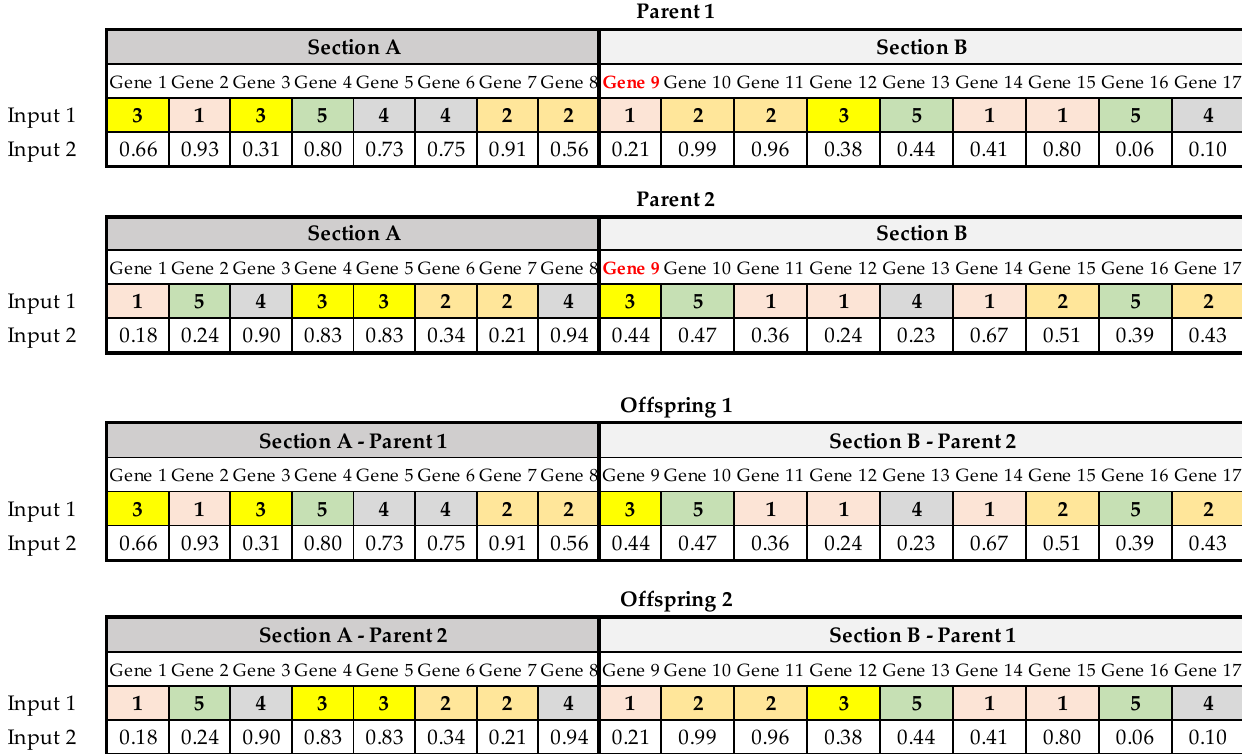
Figure 7. Crossover operator based on single crossing point. The mutation operator is applied after creating the offspring alphas, generating a random number for each offspring. If this random number is less than the probability of mutation MR, the mutation operation is performed using the swapping mutation method (exchange mutation), where two randomly chosen genes are exchanged through a SWAP movement [36,37] (see Figure 8). Figure 8. Mutation operator based on SWAP movements. Step 7. After applying the crossover or mutation operator, infeasible offspring may be generated because one or more jobs do not have assigned the number of operations they require, so a job j appears more or fewer times in the offspring than the number of operations it must perform. As shown in Figure 9, the repair mechanism randomly ex ‐ changes one of the remaining operations for a missing one.